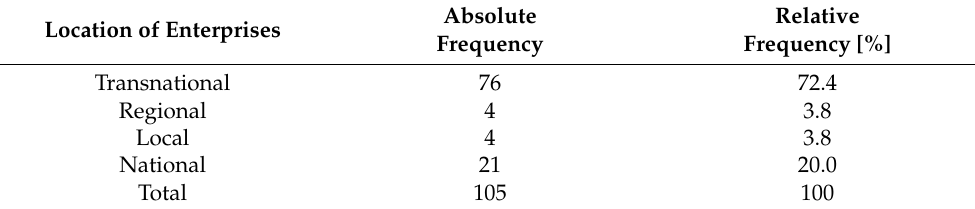
Table 2. Structure of the studied sample by location of enterprises.